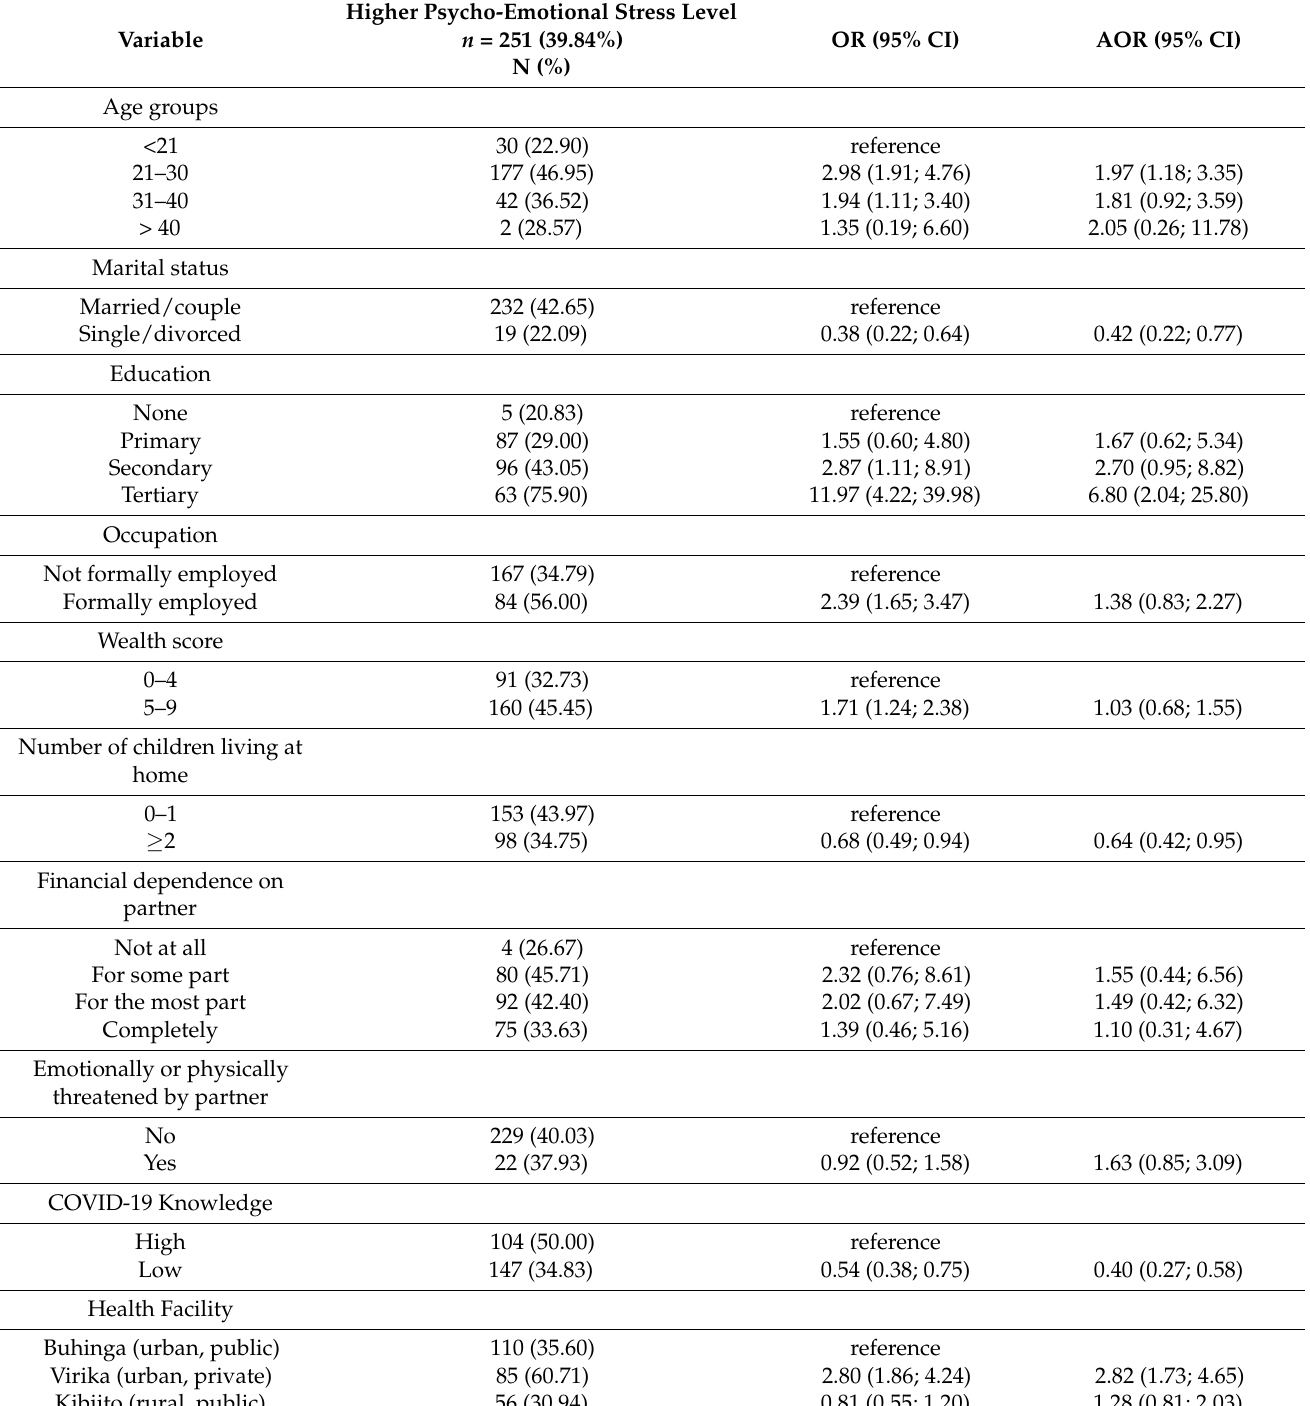
Table 4. Factors associated with higher psycho-emotional stress level calculated by logistic regression ( n = 630).